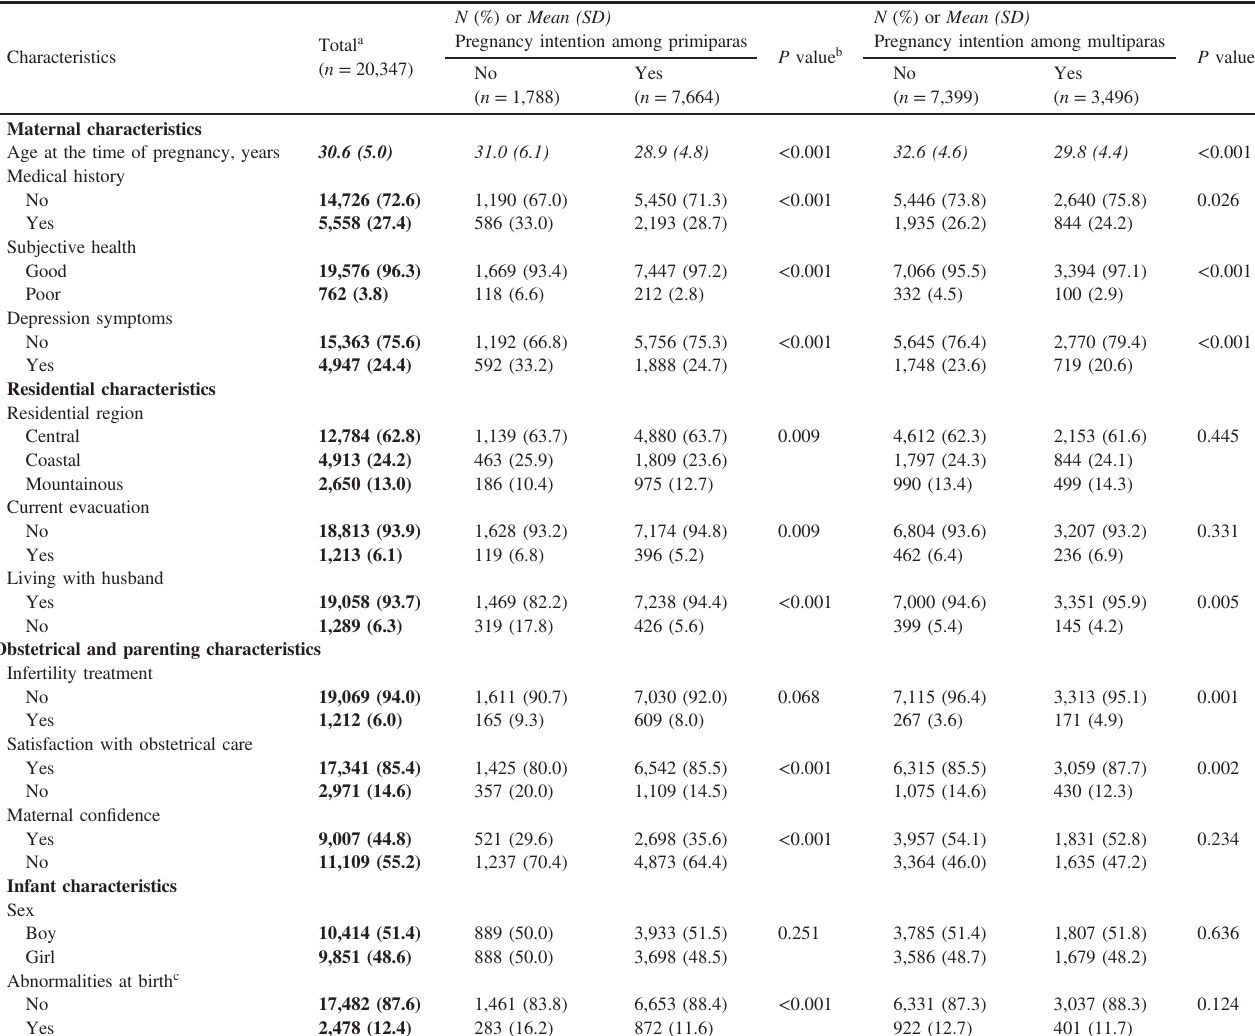
Table 1. Respondents ’ characteristics and di ff erences by parity and pregnancy intention